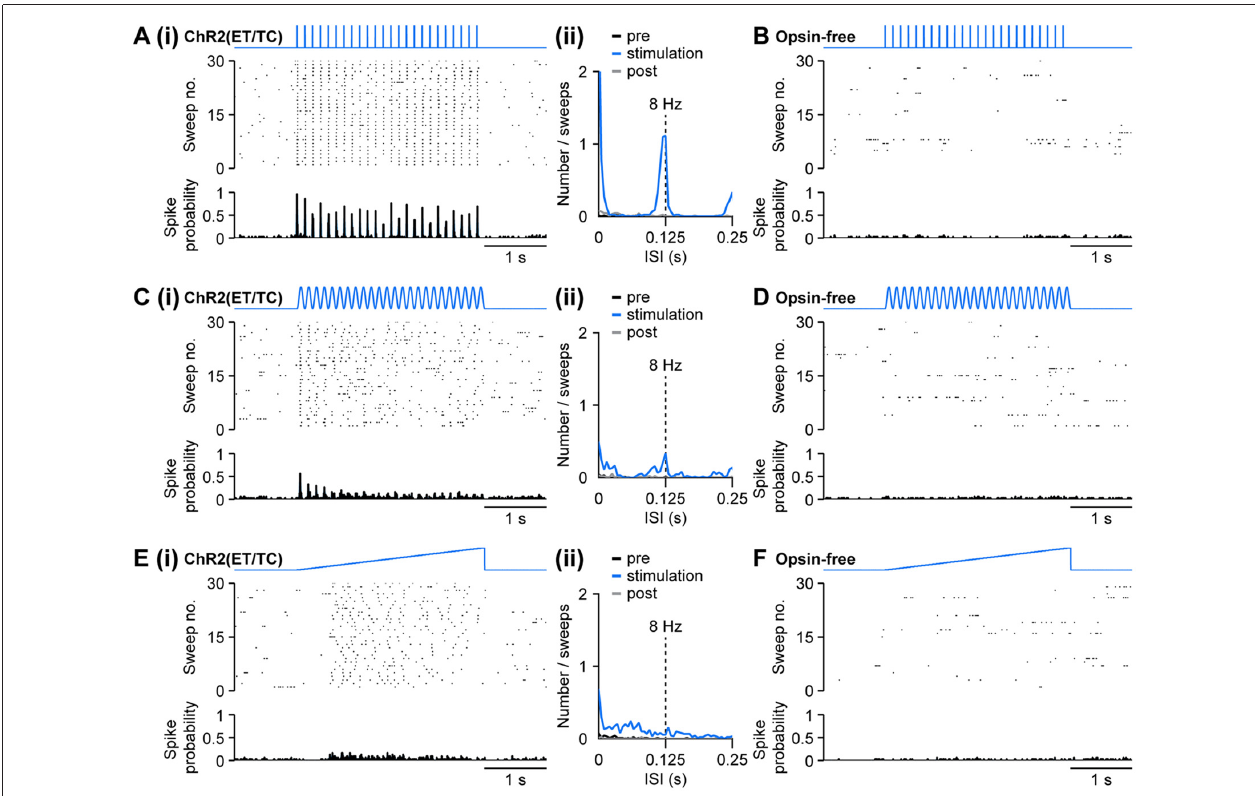
FIGURE 4 | Optogenetic activation of pyramidal neurons in the neonatal PFC by different patterns of light stimulation in vivo . (Ai) Representative raster plot and spike probability histogram displaying the firing of ChR2(ET/TC) transfected layer II/III pyramidal neurons in response to 30 sweeps of repetitive light pulses (473 nm, 3 ms, 14 mW/mm 2 ) at 8 Hz recorded from a neonatal mouse after IUE at E15.5. (ii) Corresponding inter-spike interval (ISI) histogram averaged for 3 s before light stimulation (pre, black), 3 s during ramp stimulation (stimulation, blue), and 3 s after light stimulation (post, gray). (B) Same as (Ai) for an opsin-free control animal. (Ci,ii,D) Same as (Ai,ii,B) for sinusoidal light stimulation. (Ei,ii,F) Same as (Ai,ii,B) for ramp light